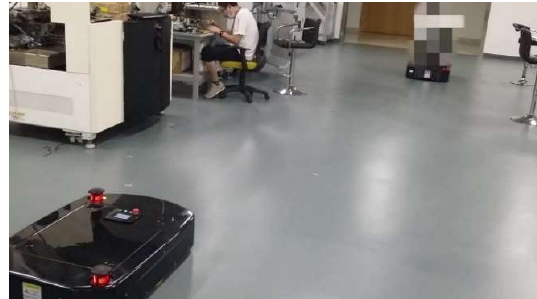
Figure 13. Experimental scene.